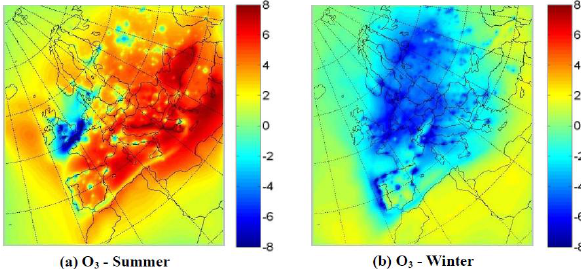
Fig. 5. Predicted reduction (base case – emissions reduction sce- nario) in ground-level concentrations (ppb) of O 3 after a 50% re- Figure 5. Predicted reduction (base case - emissions reduction scenario) in ground-level 3 duction of NO x emissions during (a) the modeled summer period concentrations (ppb) of O 3 after a 50% reduction of NO x emissions during (a) the modeled 4 and (b) the modeled winter period. A positive value corresponds to summer period and (b) the modeled winter period. A positive value corresponds to a decrease. 5 a